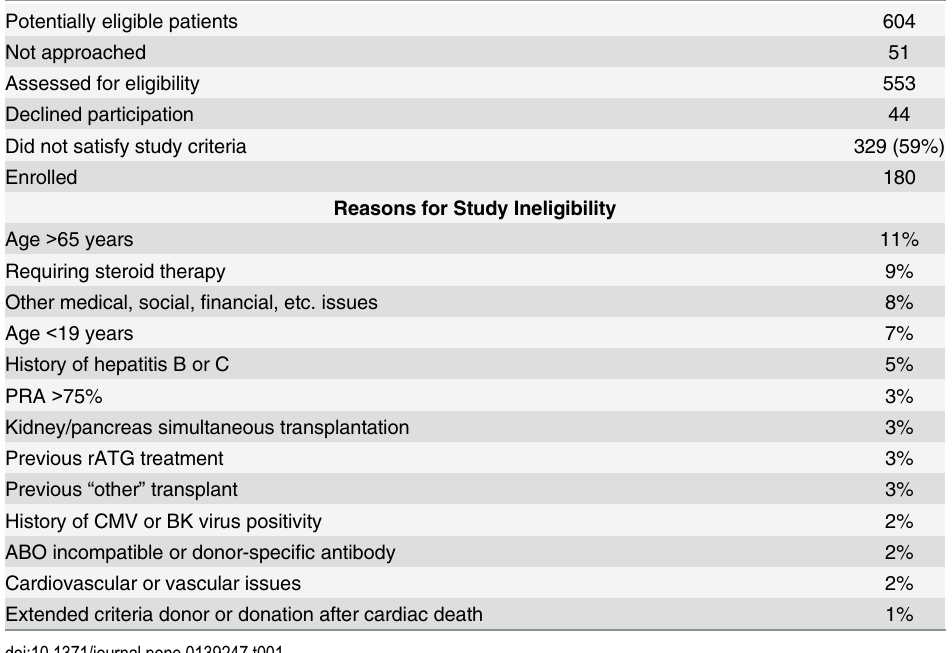
Table 1. CONSORT Accounting of Patients Screened for Study